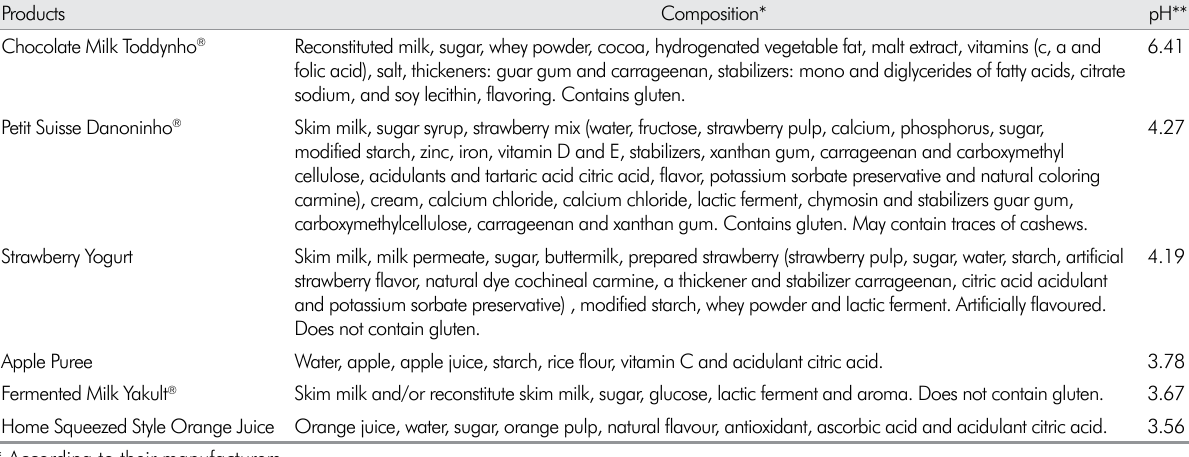
Table 1. Composition and pH of the tested foods and